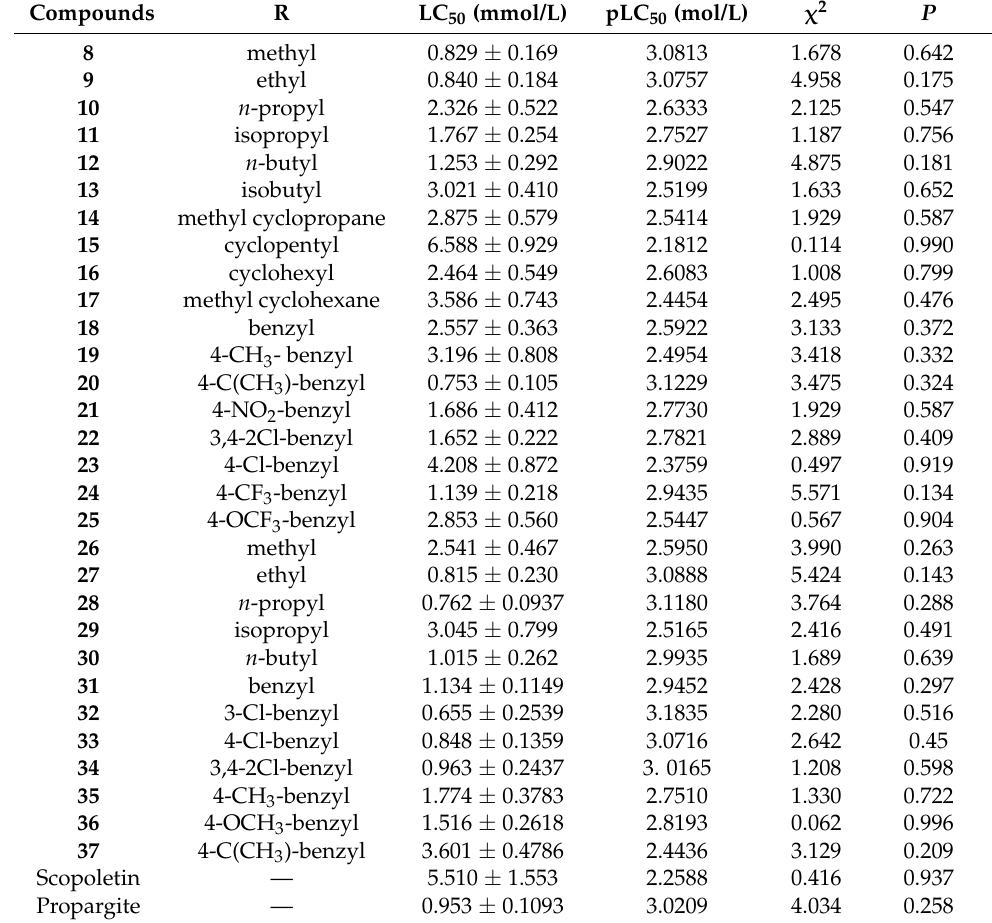
Table 1. Contact activity of scopoletin and its phenolic ether derivatives ( 8 – 37 ) against female adults of T. cinnabarinus (48